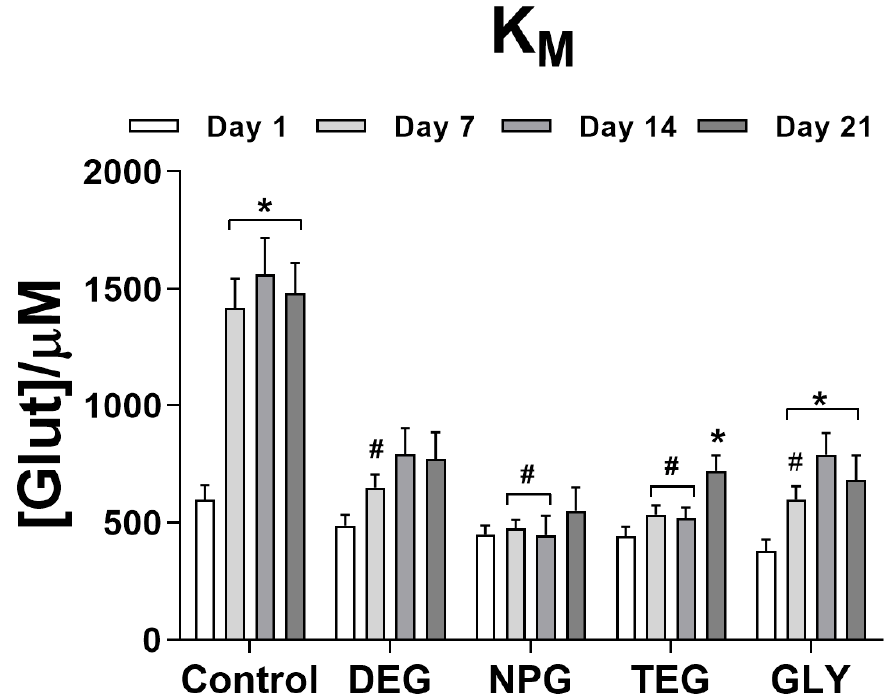
Figure 4. Bar plot of the variation of K M for different biosensor designs (n = 4): Pt c /PPD/PEI(1%) 2 /GlutOx 5 /Glycol(0.1%). Pt c : Pt cylinder 1 mm long; GlutOx: L-glutamate oxidase; PPD: ortho-phenylenediamine polymer; PEI: polyethyleneimine, DEG: diethylene glycol, NPG: neopentyl glycol, TEG: triethylen glycol, GLY: glycerol. The subscript number represents the number of dips and in brackets, the concentration of the glycol. Values are expressed as mean ± SEM. * p < 0.001 vs. Day 1 of the respective group. # p < 0.001 vs. control design.